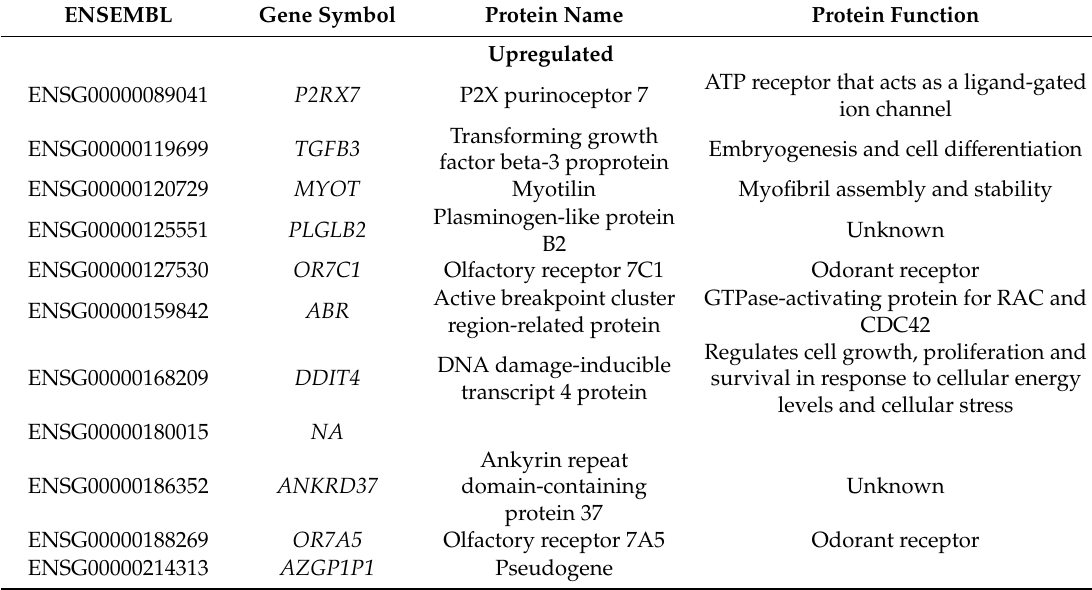
Table 5. DEGs found both in the SN and putamen from PD patients and